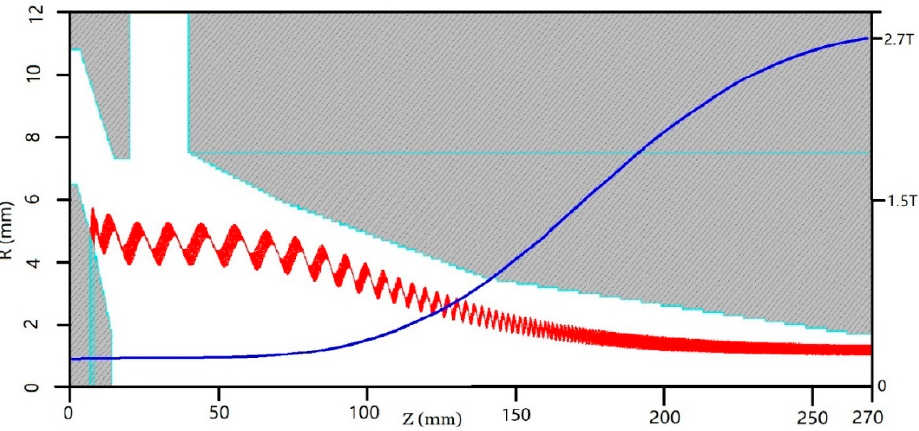
Figure 5. Optimized geometry, magnetic field profile and beam trajectory of MIG by Magic code.